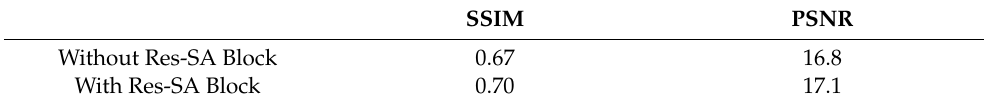
Table 2. Quantitative evaluation of the performance of the model with/without Res-SA block.